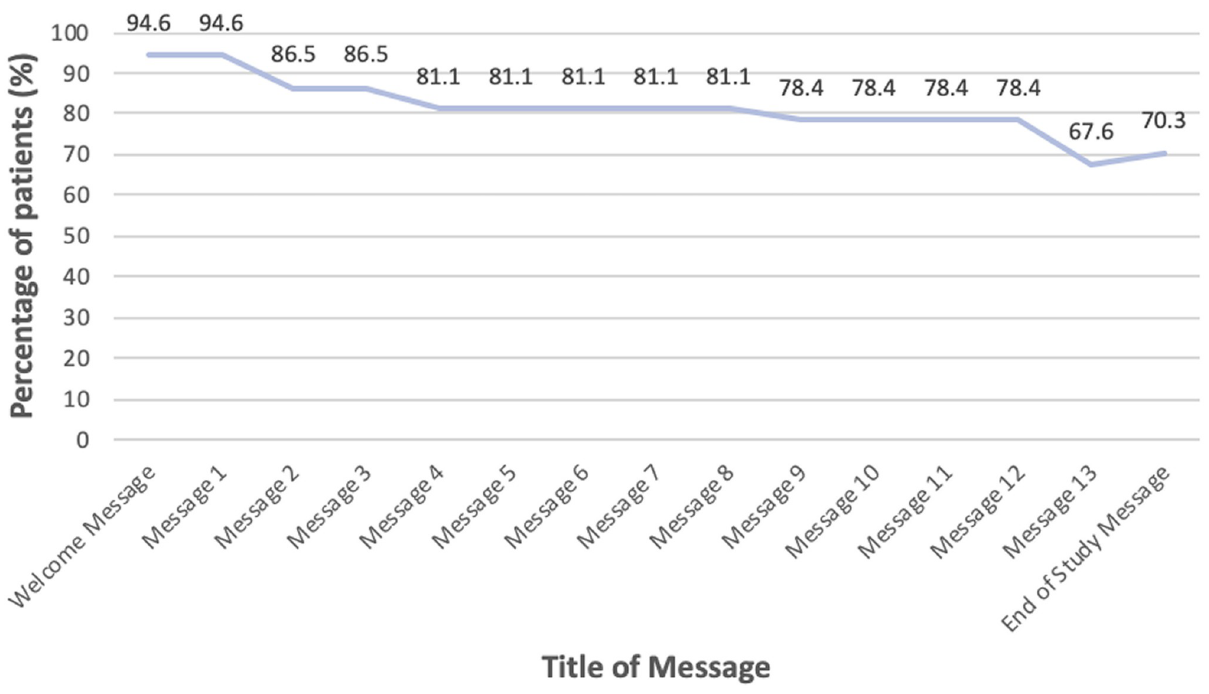
Fig 3. Patient interactions with motivational messages.